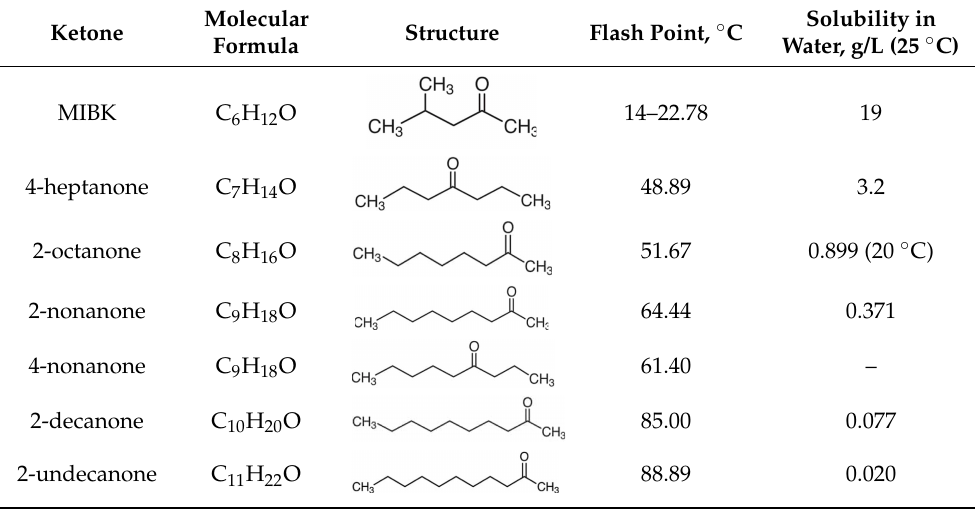
Table 2. Ketone flash point and solubility in water